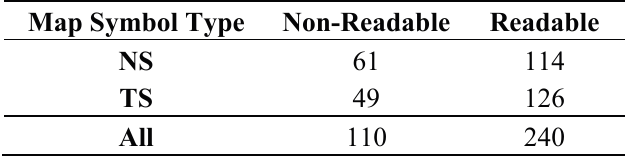
Table 3. The number of readable and non-readable map